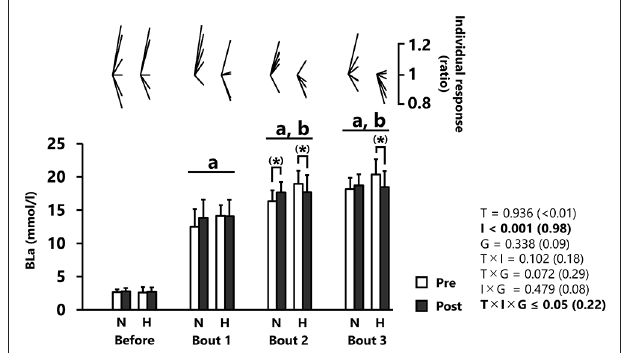
FIGURE 2 | Peak power output (PPO). All values are expressed as mean with SD for error bars. Individual response is shown as a ratio of the value between pre and post within participants. Significance level and effect size are expressed as P -value (Cohen’s d ) for main effects and interactions. * p = 0.001 Compared with pre-test. a p < 0.01 Compared with bout 1. b p < 0.01 Compared with bout 2. N, normoxic group; H, hypoxic group; T, time; I, interval; G, group.